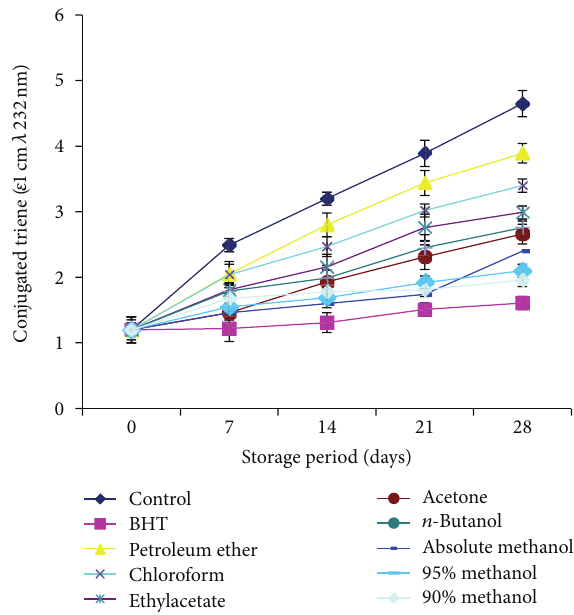
Figure 6: Relative increase in conjugated trienes content (CT) of sunflower oil stabilized with C. viminalis leaves